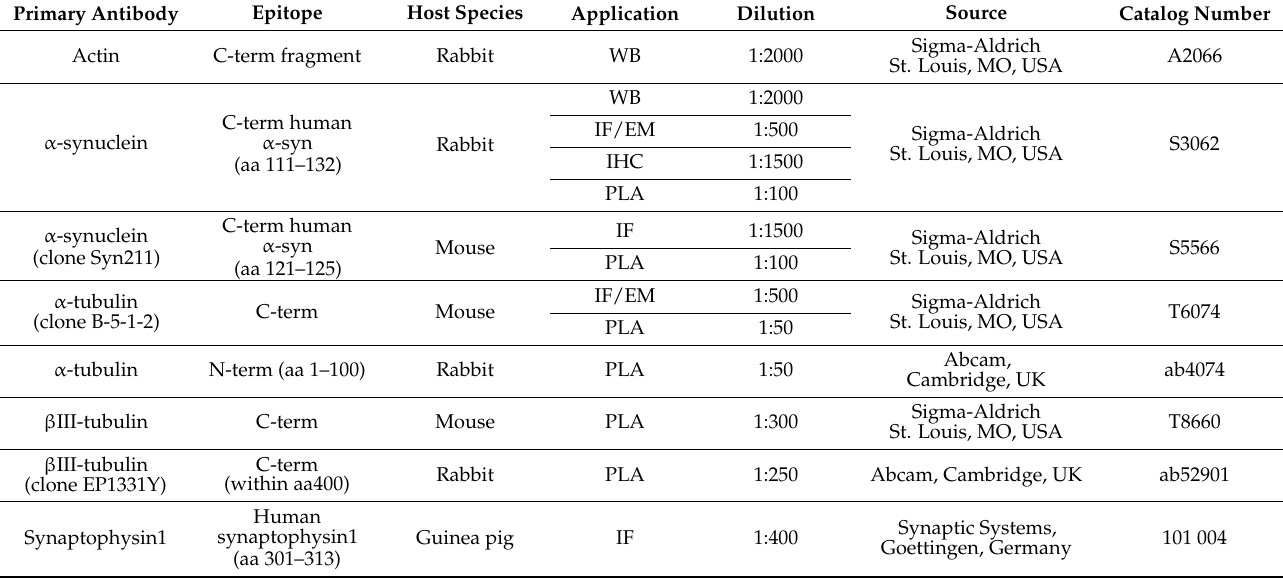
Table 1. List of primary